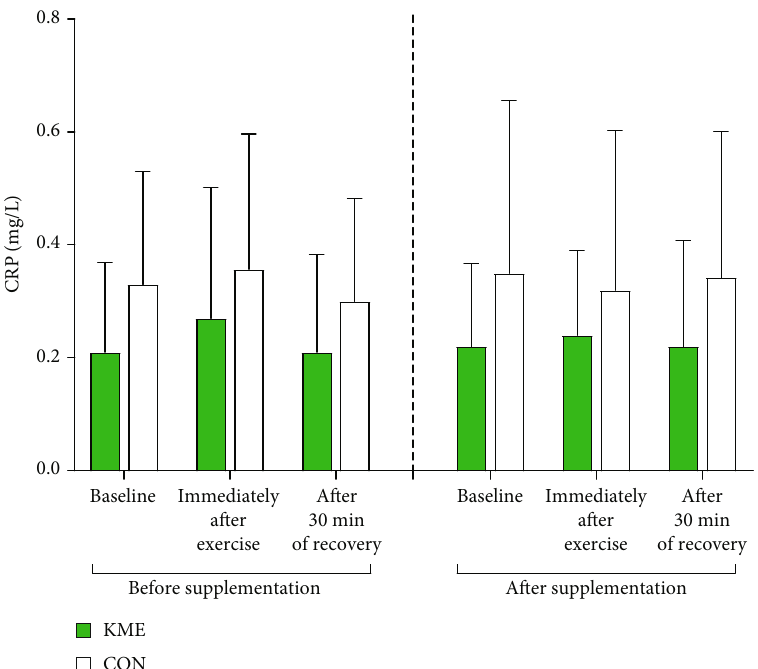
Figure 6: Changes in C-reactive protein levels during the 2,000m rowing ergometer exercise trials before and after supplementation ( means ± SD ). There was no di ff